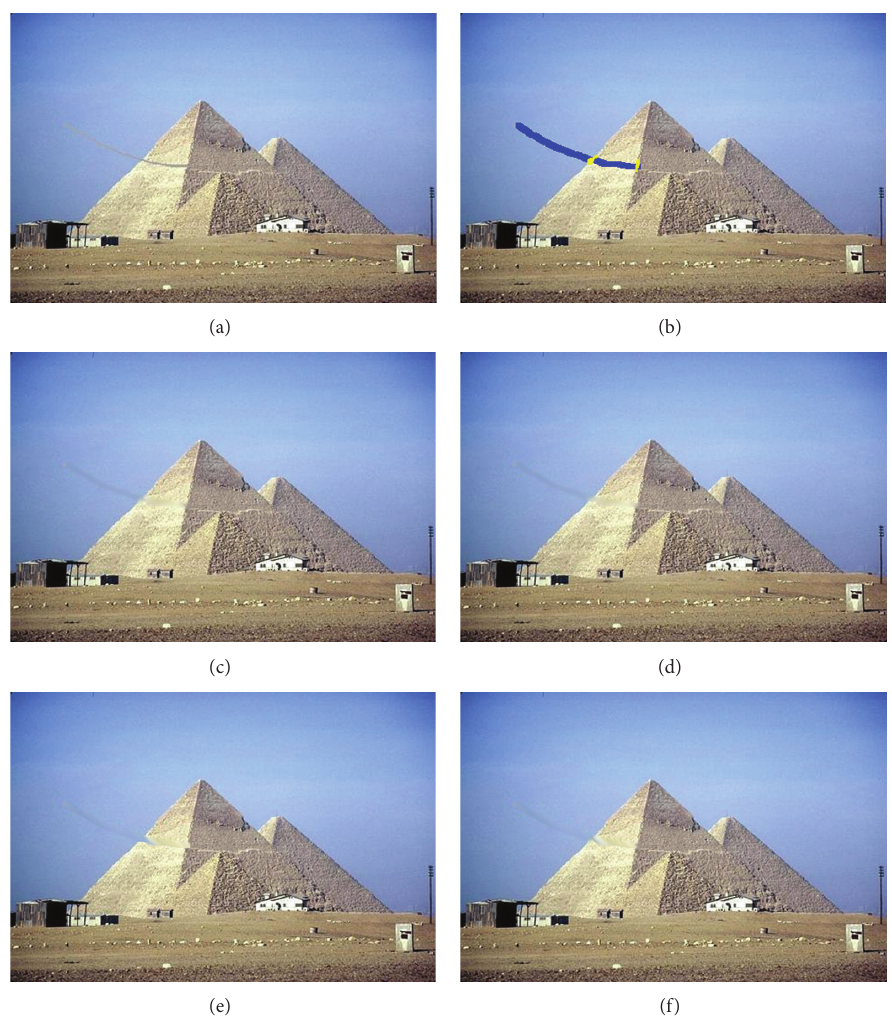
Figure 3: Visual comparison of the proposed methods; (a) simulation of a natural defect; (b) the corresponding masks; (c) result of the Oliveira method; (d) result of the proposed adaptation of Oliveira method; (e) result of the Hadhoud method; (f) result of the proposed adaptation of Hadhoud method.